Question: Summarize what this figure shows in one sentence.
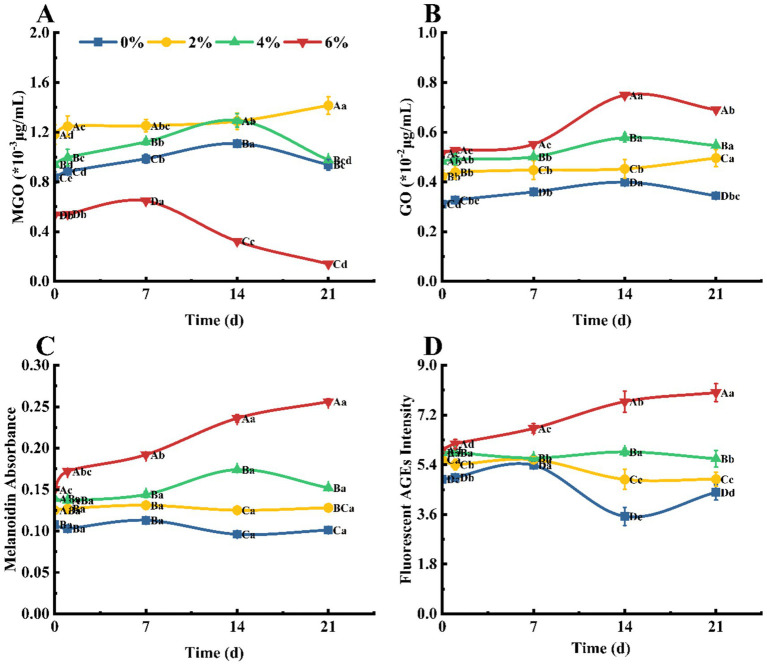
Answer: Contents of non-enzymatic glycation products MGO (A) ; GO (B) , Melanoidin (C) and Fluorescent AGEs (D) in 4 groups milk (0, 2, 4 and 6% milk fat) during storage for 21 days ( n = 3).